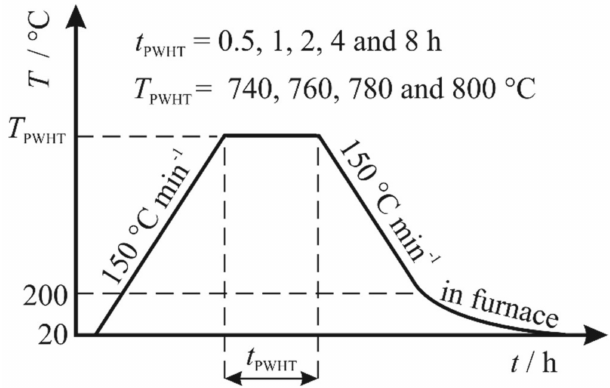
Figure 3. Schematic diagram of heat treatments; t PWHT equals soaking time at the selected annealing